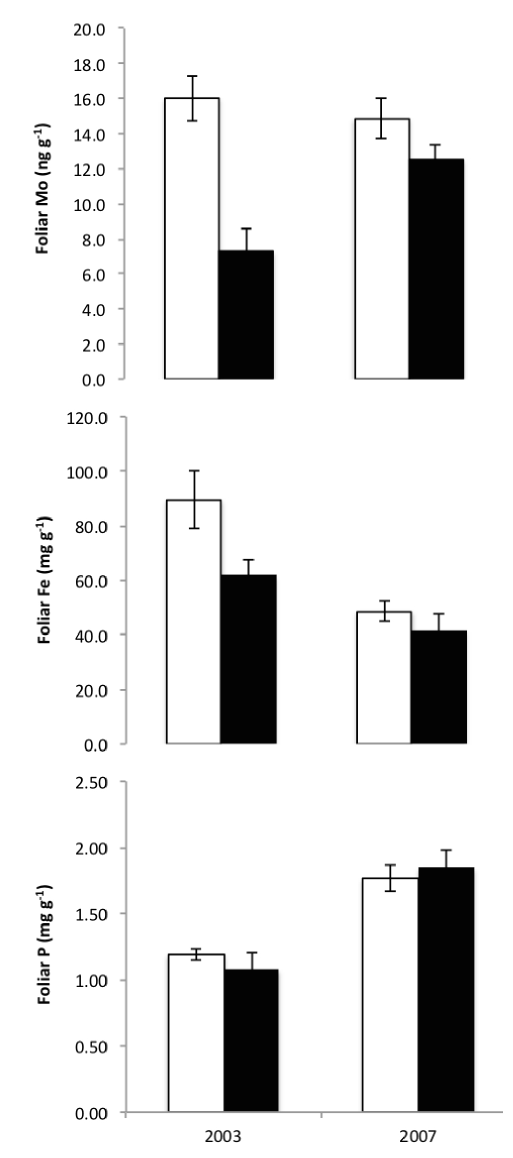
Figure 5. Effects of elevated CO 2 concentration on Mo, Fe, and P concentrations in leaves of G. elliottii sampled in 2003 and 2007 (values for Mo and Fe from 2003 are from Hungate et al., 2004).